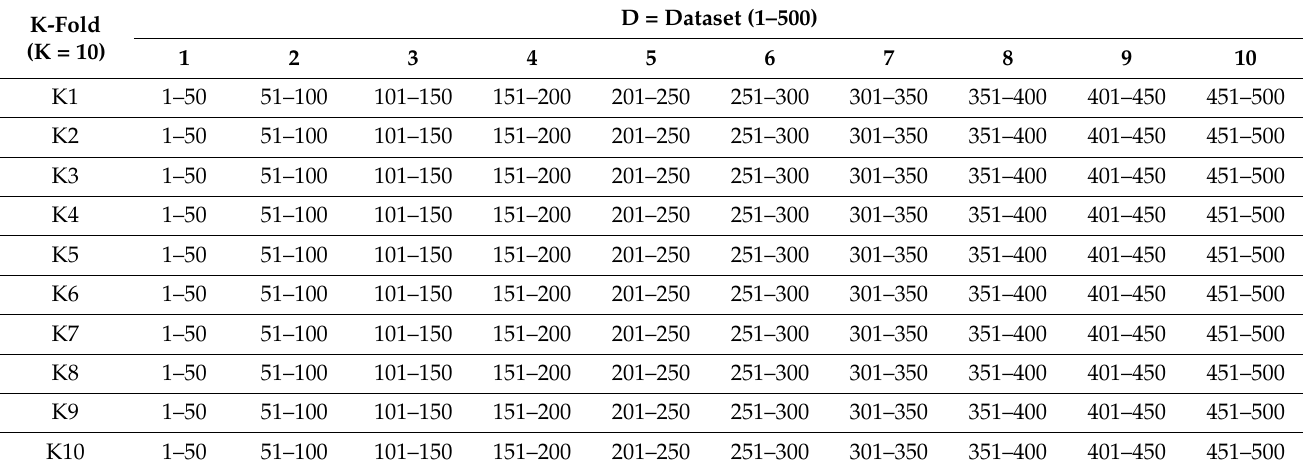
Table 10. A sample listing of randomized 10-fold cross